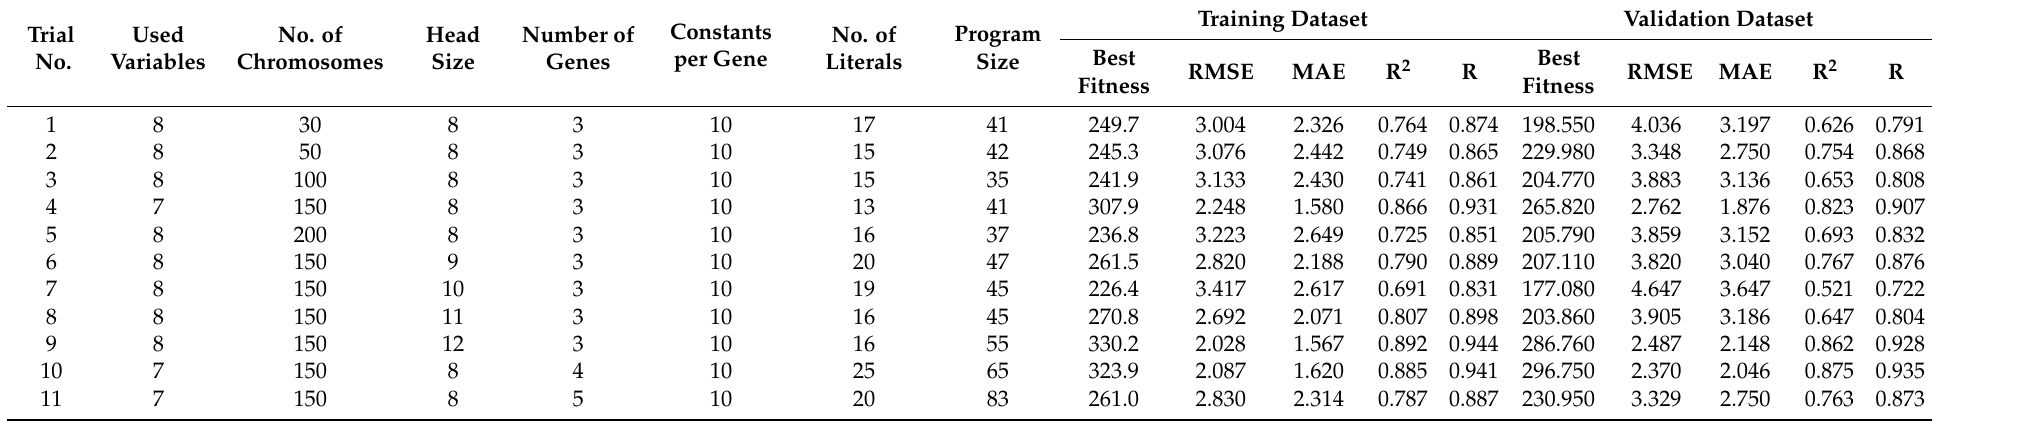
Table 3. Statistical evaluation of the trials undertaken in finding optimised